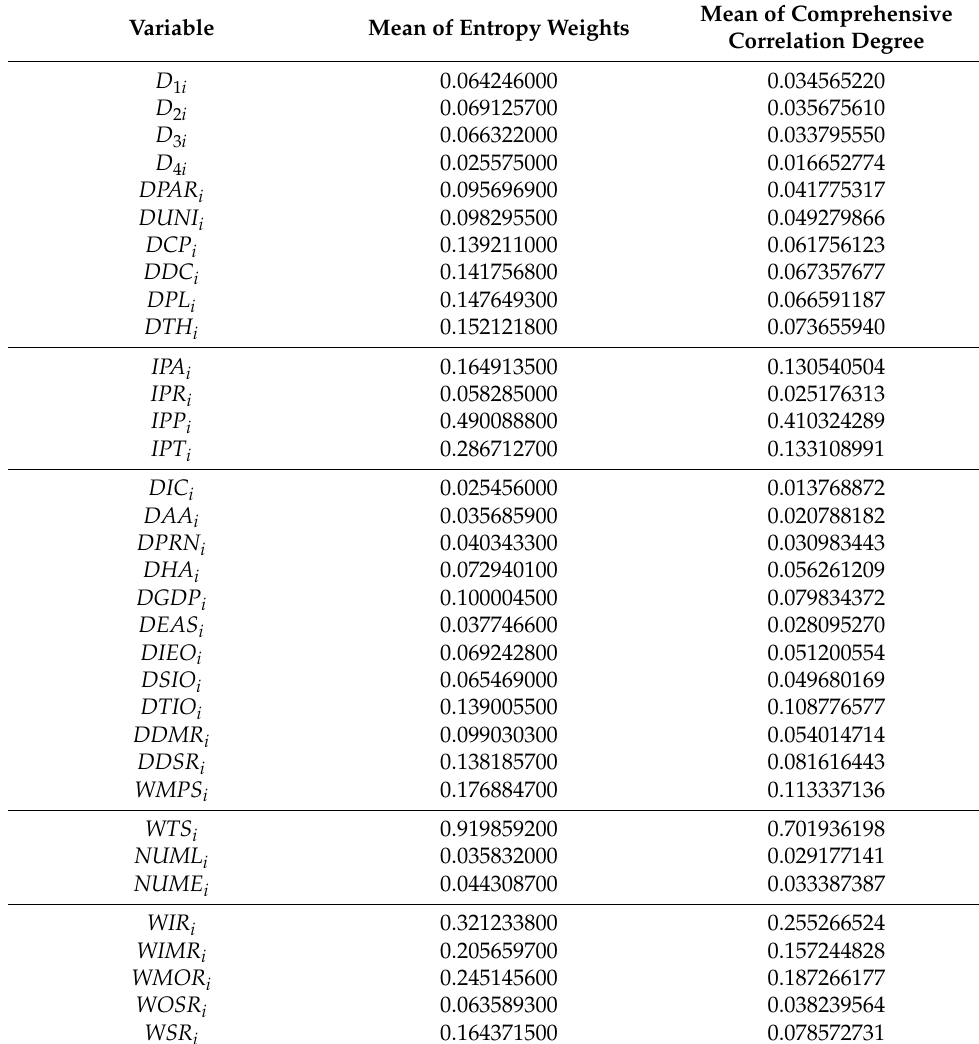
Table 3. The entropy weight of influencing factors and the average value of comprehensive correla- tion